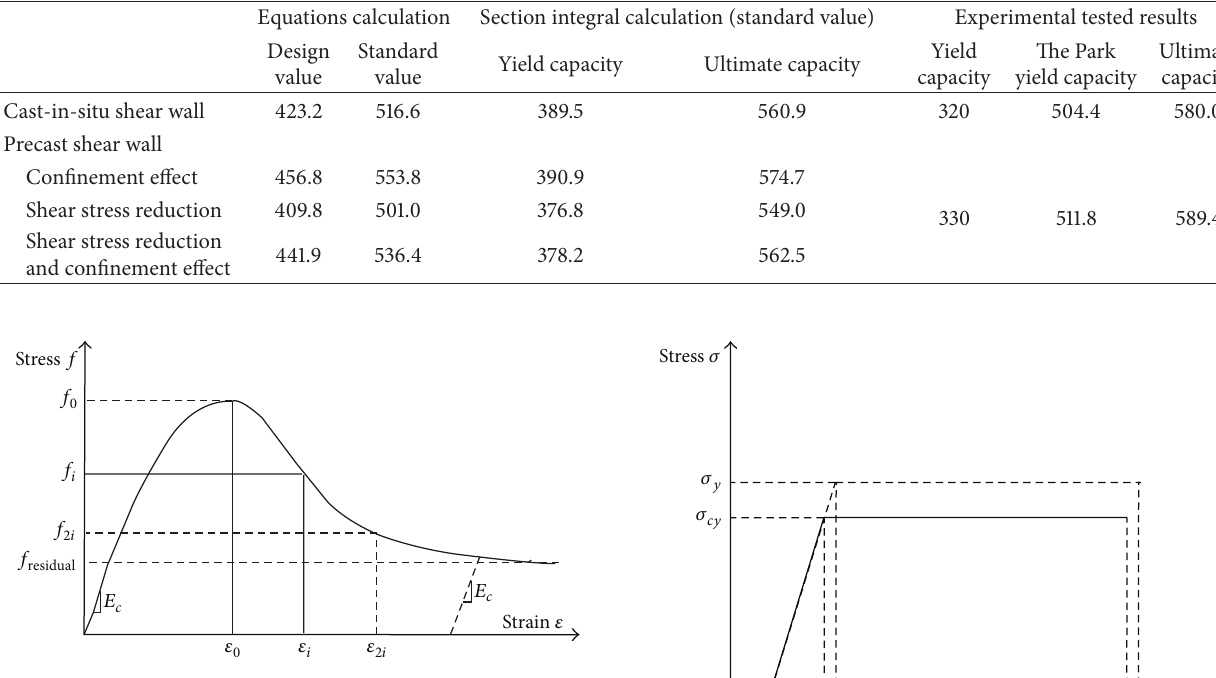
Table 1: Calculated and experimental tested results (kN).